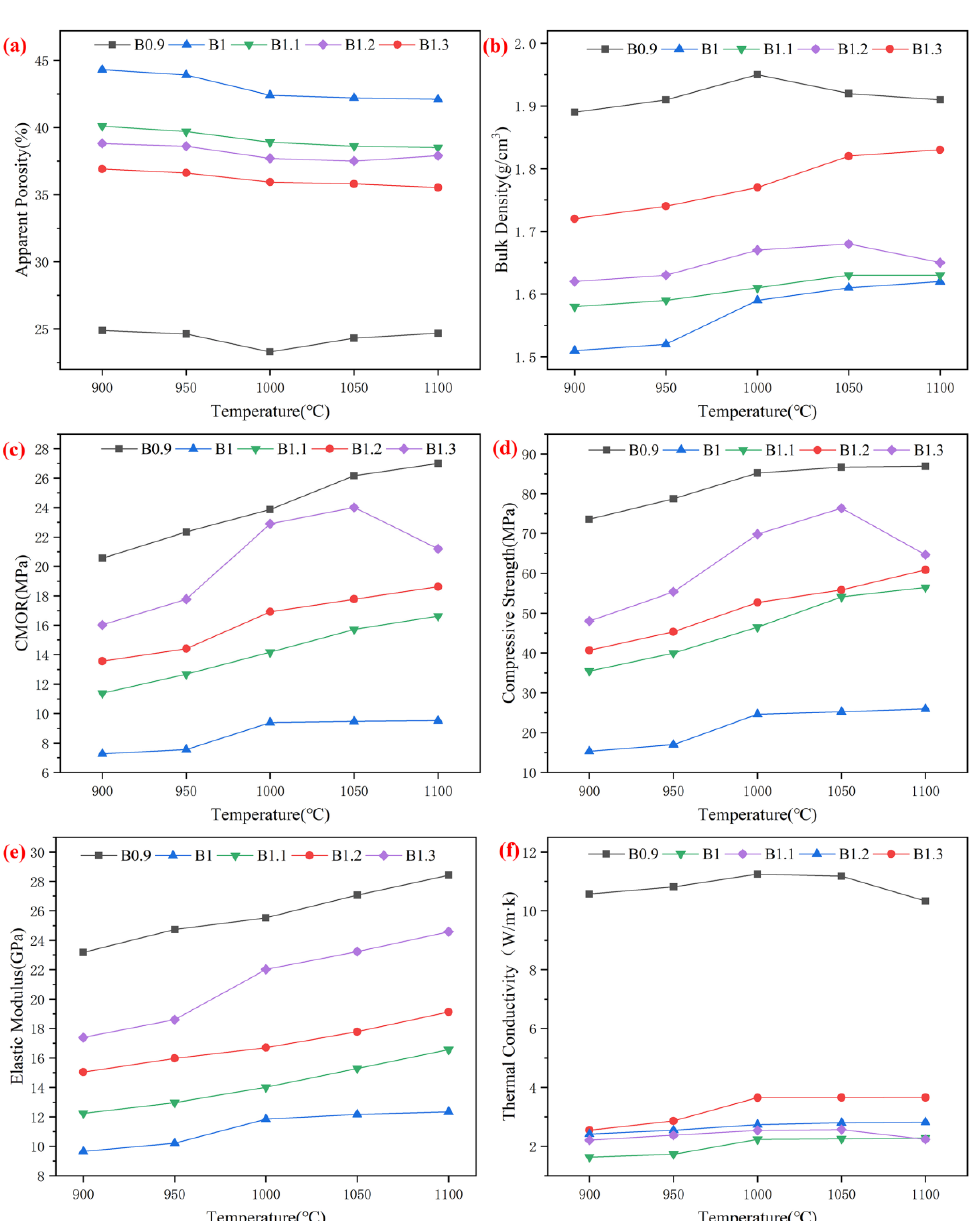
Figure 6. Effect of the H 3 BO 3 content and calcinating temperature on the mechanical and thermal properties of the BPCs ( a ) apparent porosity, ( b ) bulk density, ( c ) CMOR, ( d ) compressive strength, ( e ) elastic modulus and ( f ) thermal conductivity.